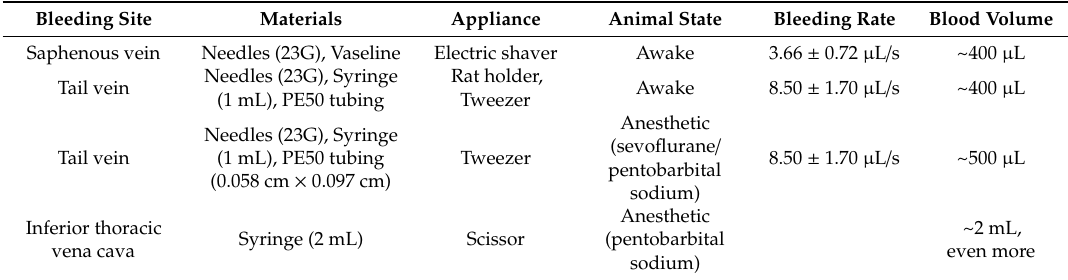
Table 1. The surgical materials for di ff erent kinds of blood sample collection